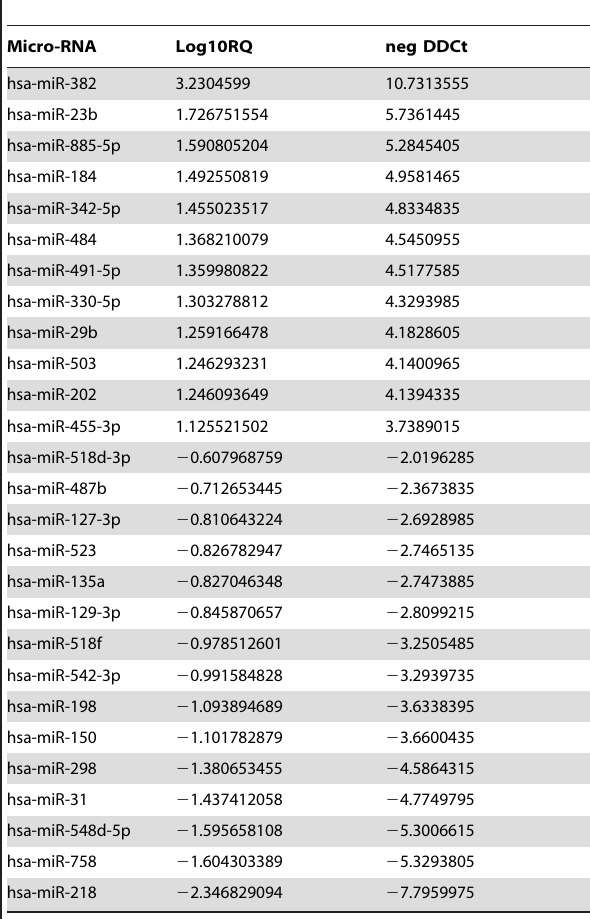
Table 1. Micro-RNA expression in etoposide resistant MCF7VP cell